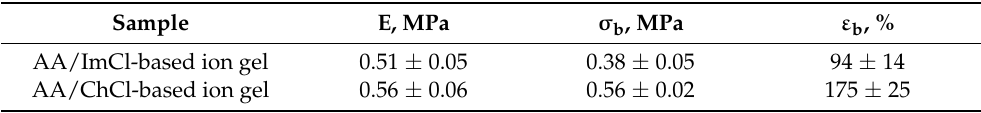
Table 2. Mechanical properties of AA/ChCl- and AA/ImCl-based polymerized ion gels measured in extension mode for samples prepared via